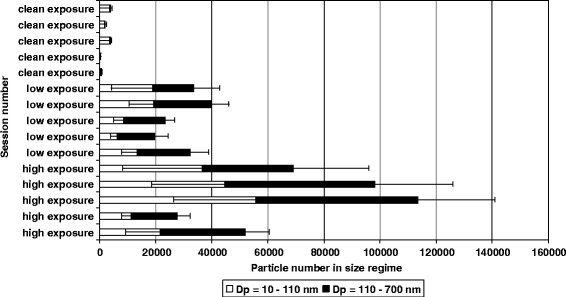
The number of particles with diameters of Dp10-110nmand of Dp110-700nmduring high, low, and clean air exposure is shown. Negative error bars for the lower size regime N10-110 show one standard variation and positive error bars for the larger size regime N110-700 show also one standard variation of the measurement. Please note that concentration values for the clean exposure sessions are multiplied by a factor of 10 (in order to make the bars visible on the figure).